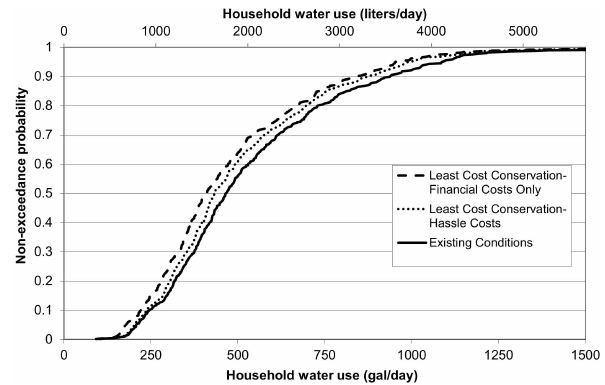
Fig. 4. CDF of water use under existing conditions and least-cost conservation.